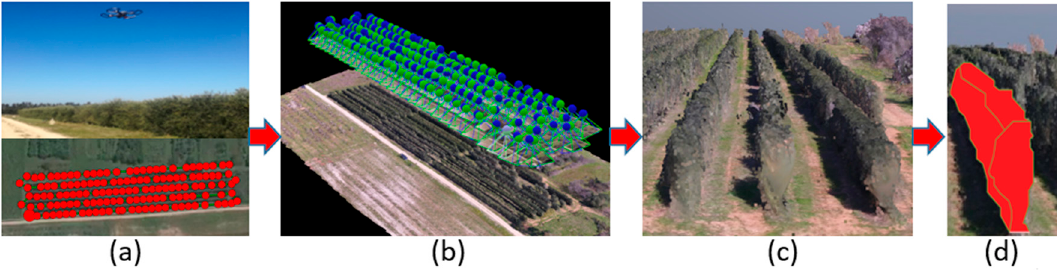
Figure 5. TRV estimations with UAV close-range photogrammetry and 3D modeling: ( a ) UAV image